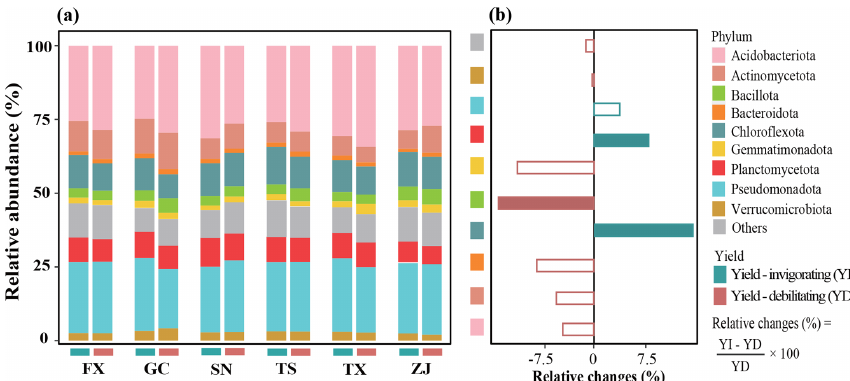
Figure 4. Key taxonomic groups in distinguishing yield-invigorating (YI) and yield-debilitating (YD) orchards. (a) Stacked bar chart showing dominant phyla affiliation in YI and YD soils for six pair-located sites, and (b) horizontal histogram depicting relative changes of dominant phyla in YI soils compared with those in YD soils.